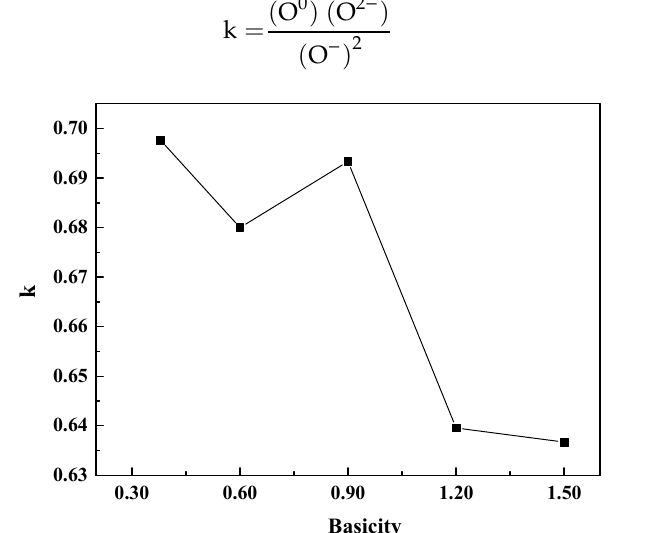
Under equilibrium conditions, an equilibrium constant k may be written according to Equation (2) [32]. The curve of k with basicity of the CaO-SiO 2 -FeO-MgO system is as shown in Figure 16. It can be seen from the figure that the mole fraction of di ff erent kinds of oxygen atom converges to a constant value when the basicity is above 1.20.